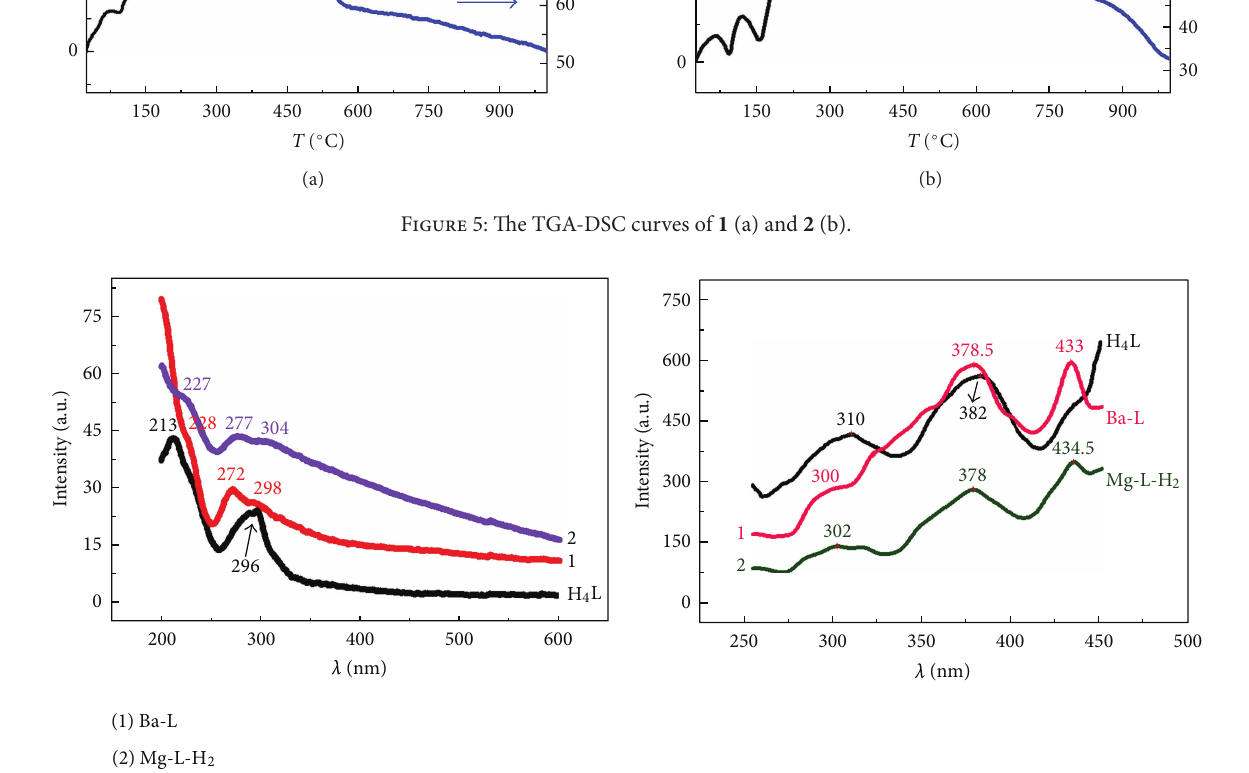
F 6: e solid state ��-�is spectra (a) and �uorescent spectra (b) of the two compounds and the li�and � L under the excitation of ��5nm. �ote: the �uorescent intensity decay for � T attenuation and those of the other two are